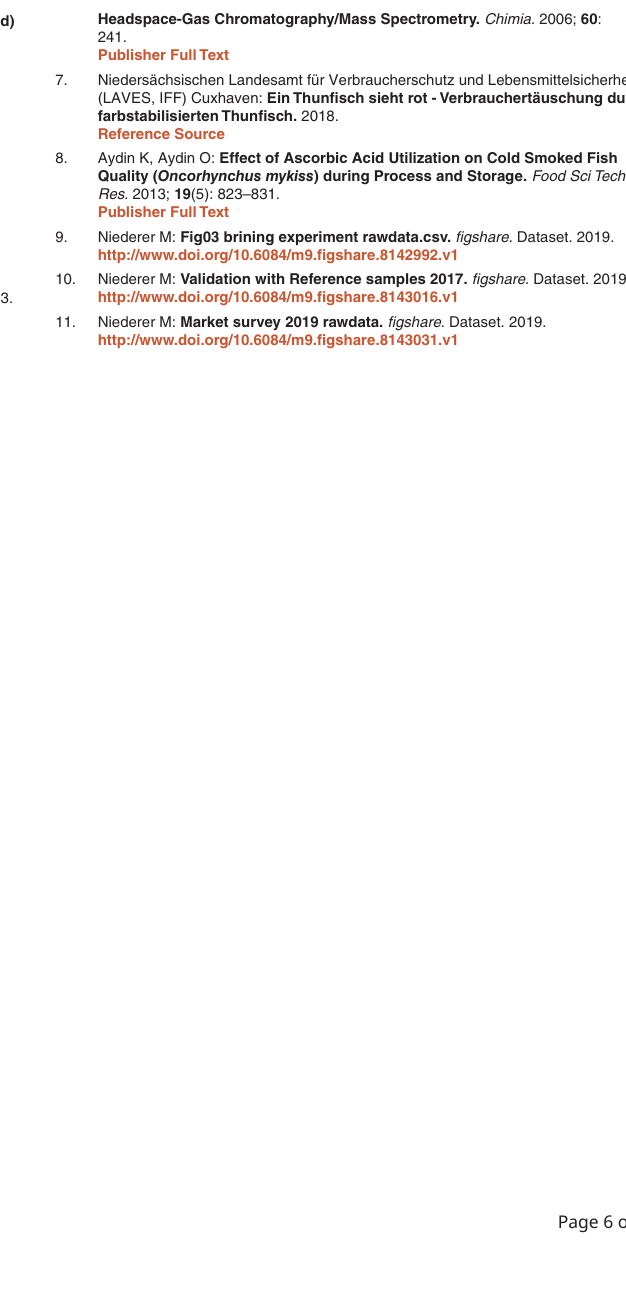
Figshare: Market survey 2019 rawdata. https://doi.org/10.6084/ m9.figshare.8143031.v1